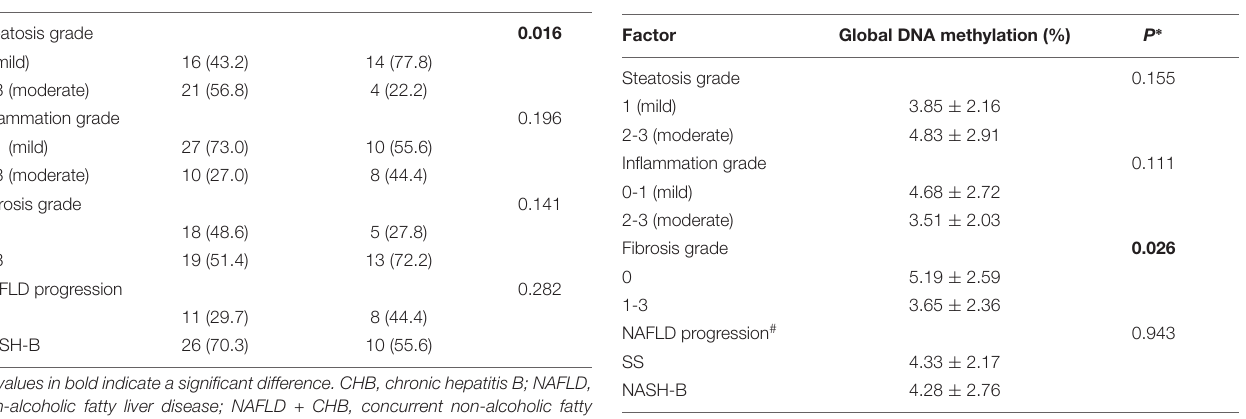
FIGURE 1 | Hepatic global DNA methylation levels based on chronic hepatitis B status. Data are expressed as means with standard deviation (SD). CHB, chronic hepatitis B; NAFLD, non-alcoholic fatty liver disease; NAFLD + CHB, concurrent non-alcoholic fatty liver disease and chronic hepatitis B. P- value was adjusted for age, sex, and body mass index. TABLE 3 | Global DNA methylation levels for each histological grade across the study